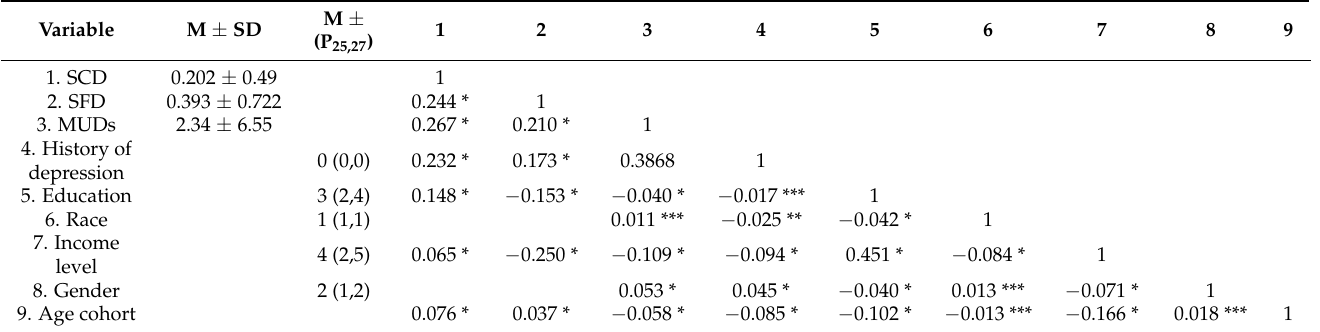
Table 1. Spearman correlation coefficients of variables among